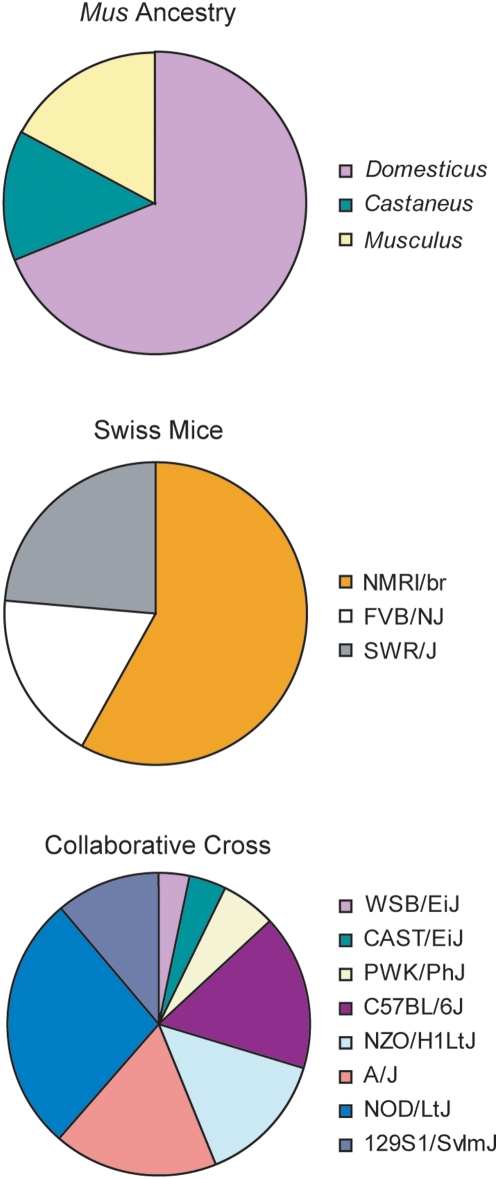
Inbred mouse contributions to CD-1 genomic variation as determined by structure analysis.Outbred CD-1 mice are represented by three pie charts that are partitioned into K colored segments to represent the CD-1 estimated membership K inbred subpopulations. Among wild-derived inbred strains (K = 3) representing the Mus subspecies, CD-1 mice are mostly M. m. domesticus. Among Swiss inbred mice (K = 3), CD-1 mice share the most genetic similarity with NMRI/br. CD-1 mice are 58% NMRI/br, 24% SWR/J and 18% FVB/NJ. Among CC inbred mice (K = 8), outbred CD-1 mice are most geneticly similar to NOD/LtJ (27%) and less similar to the other 7 strains (3% WSB/EiJ, 4% CAST/EiJ, 6% PWK/PhJ, 17% C57BL/6J, 14% NZO/H1LtJ, 18% A/J, and 11% 129S1/SvlmJ).